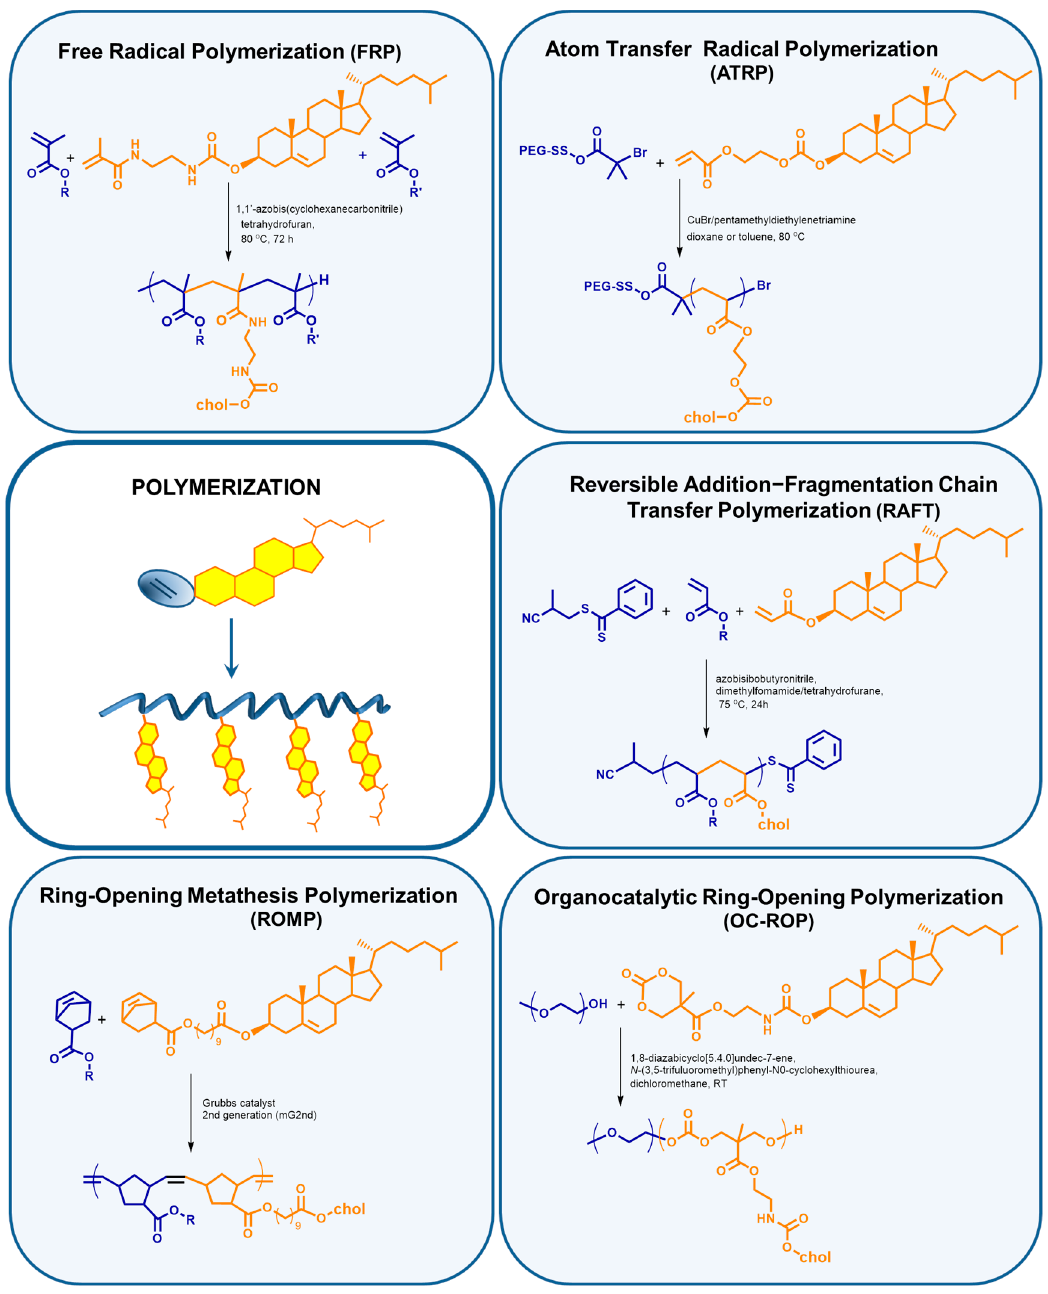
Figure 5. Types of polymerization used to obtain polymers with cholesterol moieties as side chains, and reaction examples [30,32,34–36].